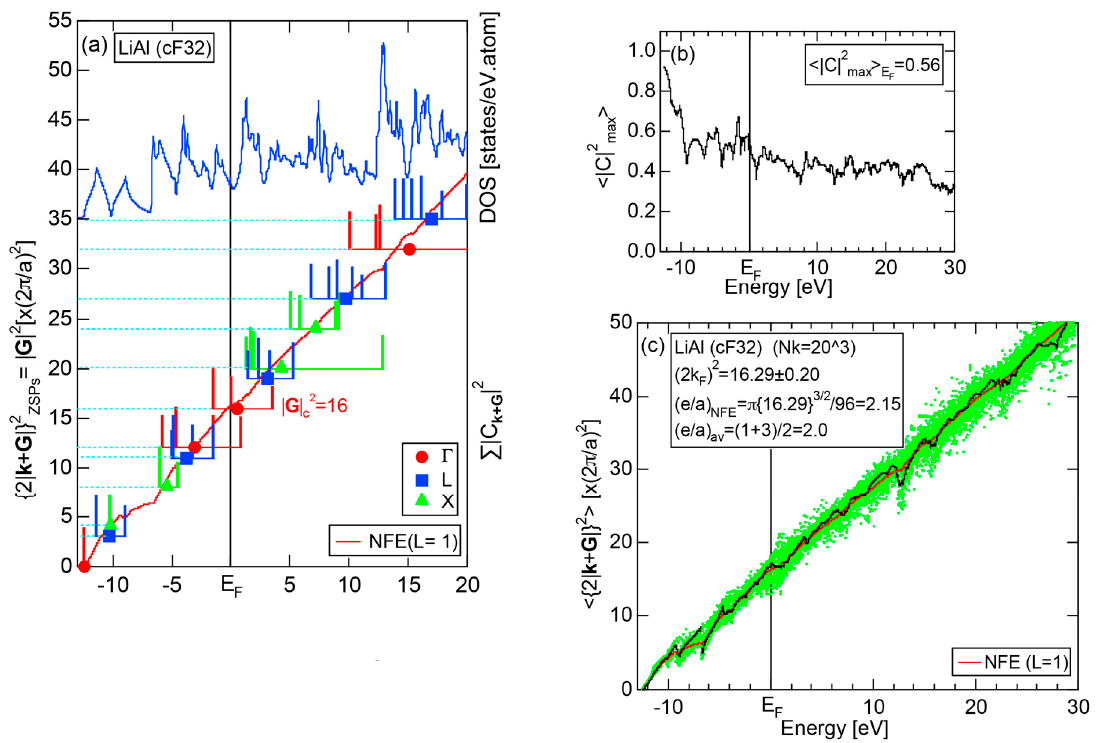
Figure 59. ( a ) FLAPW-Fourier spectra at symmetry points Γ , L, X of the fcc Brillouin zone along with the total DOS; ( b ) C max2 | C | 2 and ( c ) Hume-Rothery plot for LiAL (cF32) [11,41]. See caption of Figure 19b for symbols in ( c ).